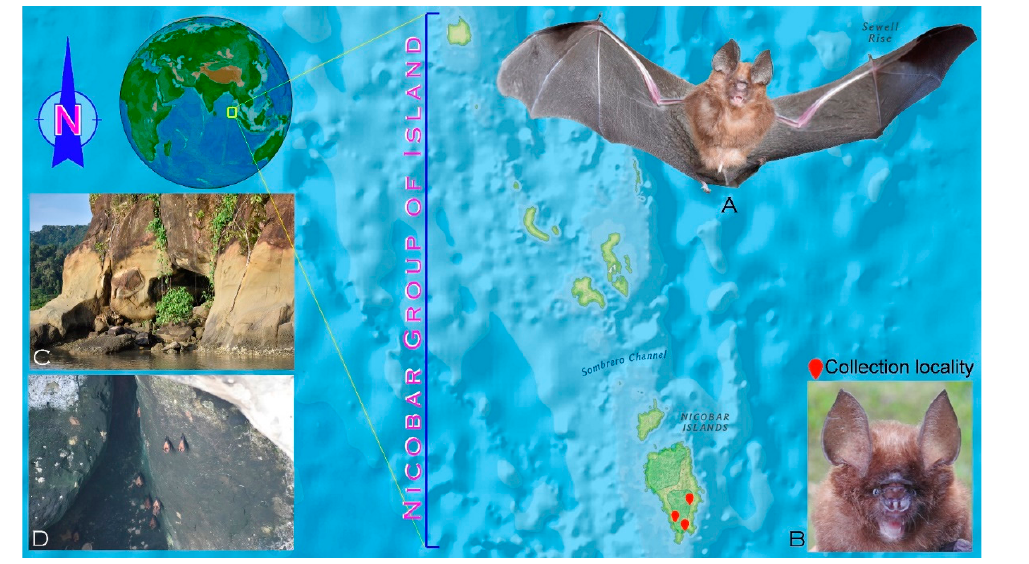
Figure 1. Map showing the collection localities of H. nicobarulae in the Great Nicobar Island (marked by a red pin). ( A ) A live specimen of H. nicobarulae captured by M. Kamalakannan during the field survey in the Andaman and Nicobar archipelago; ( B ) a frontal view of the ears and nose leaves of H. nicobarulae ; ( C , D ) the habitat of H. nicobarulae on the Great Nicobar Island, India.